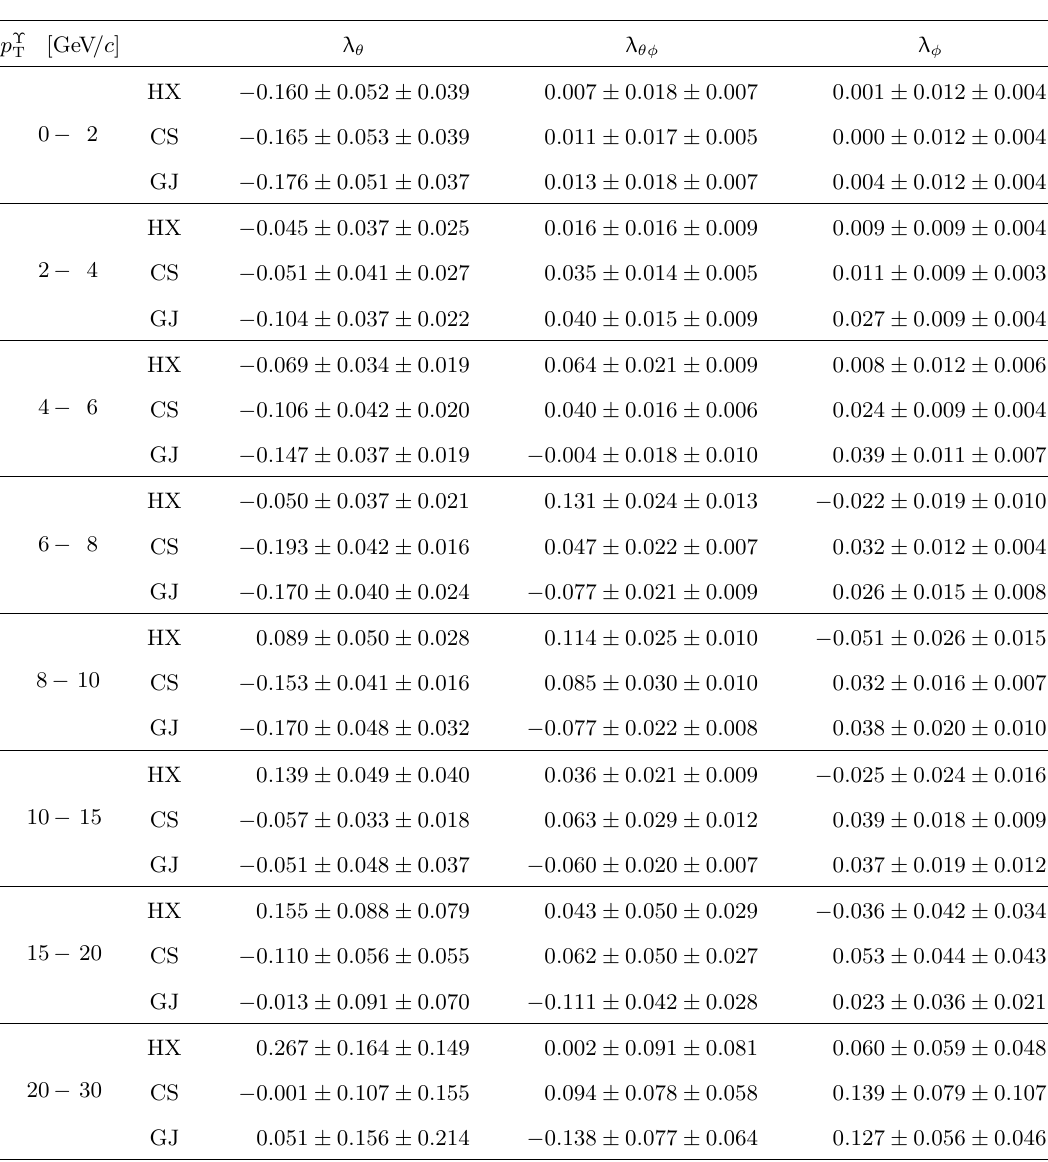
Table 17 . Values of (cid:21) (cid:18) , (cid:21) (cid:18)(cid:30) and (cid:21) (cid:30) measured in the HX, CS and GJ frames for the (cid:7)(2S) produced p at s = 7 TeV in the rapidity range 2 : 2 < y (cid:7) < 4 : 5. The (cid:12)rst uncertainty is statistical and the second